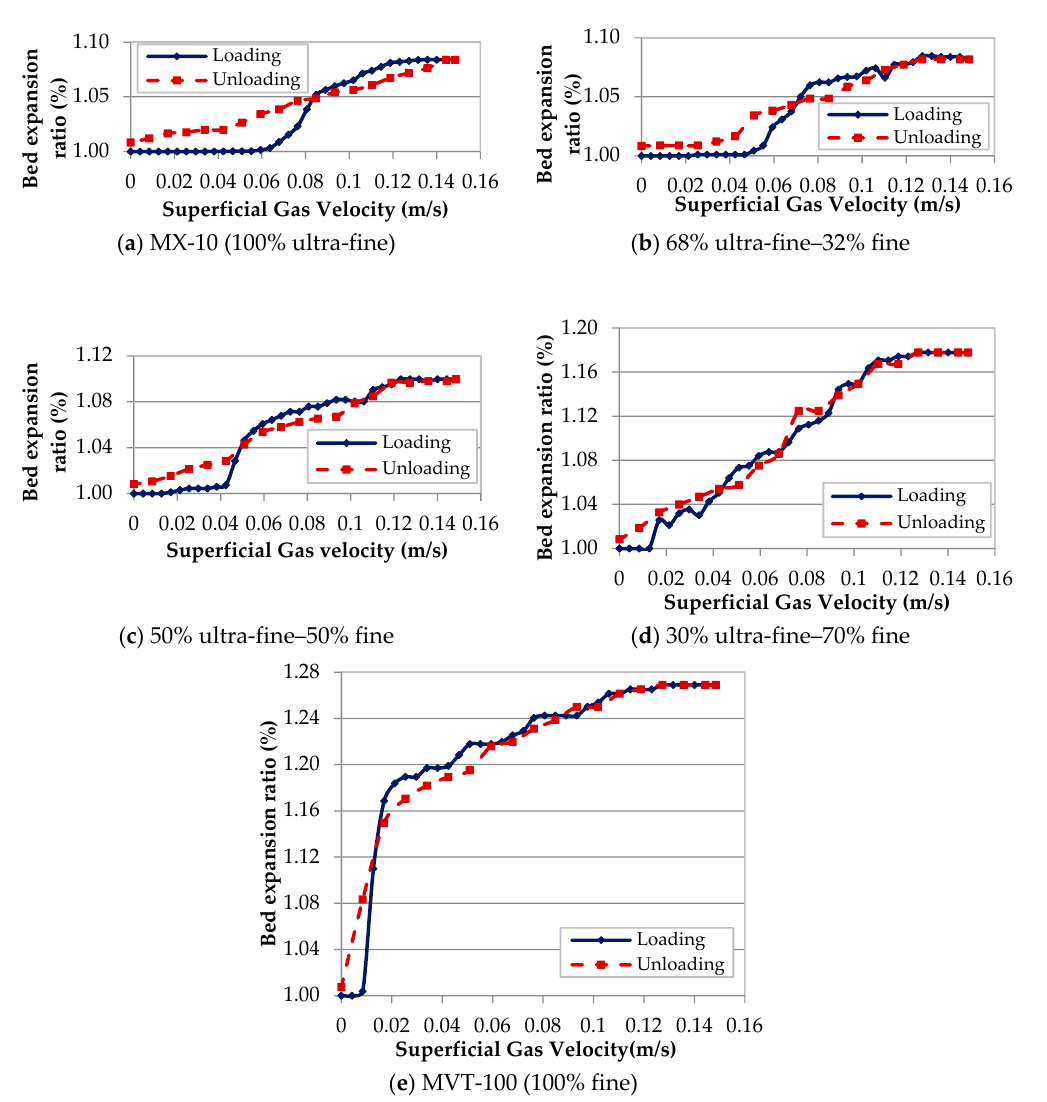
Figure 19. Bed expansion ratio ( ∆ h b / L 0 , where ∆ h b and L 0 are the current and the initial height of the bed, respectively) as a function of superficial gas velocity for different mixtures of materials. At lower superficial gas velocities (left part of the figures), the bed height for unloading is higher the calculated pseudo- 𝑈 (cid:3040)(cid:3033) for all mixtures. In addition, by increasing the percentage of ultra-fine